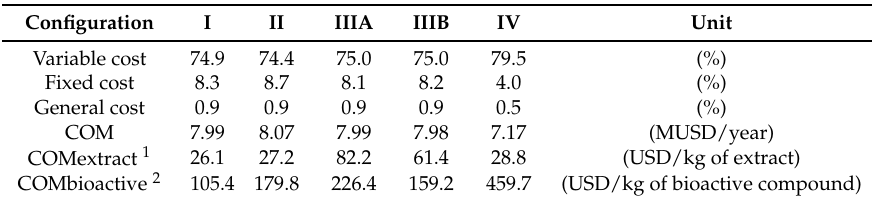
Table 4. Cost of manufacturing (COM) calculated for the evaluated annatto seeds-sugarcane biorefinery configurations.